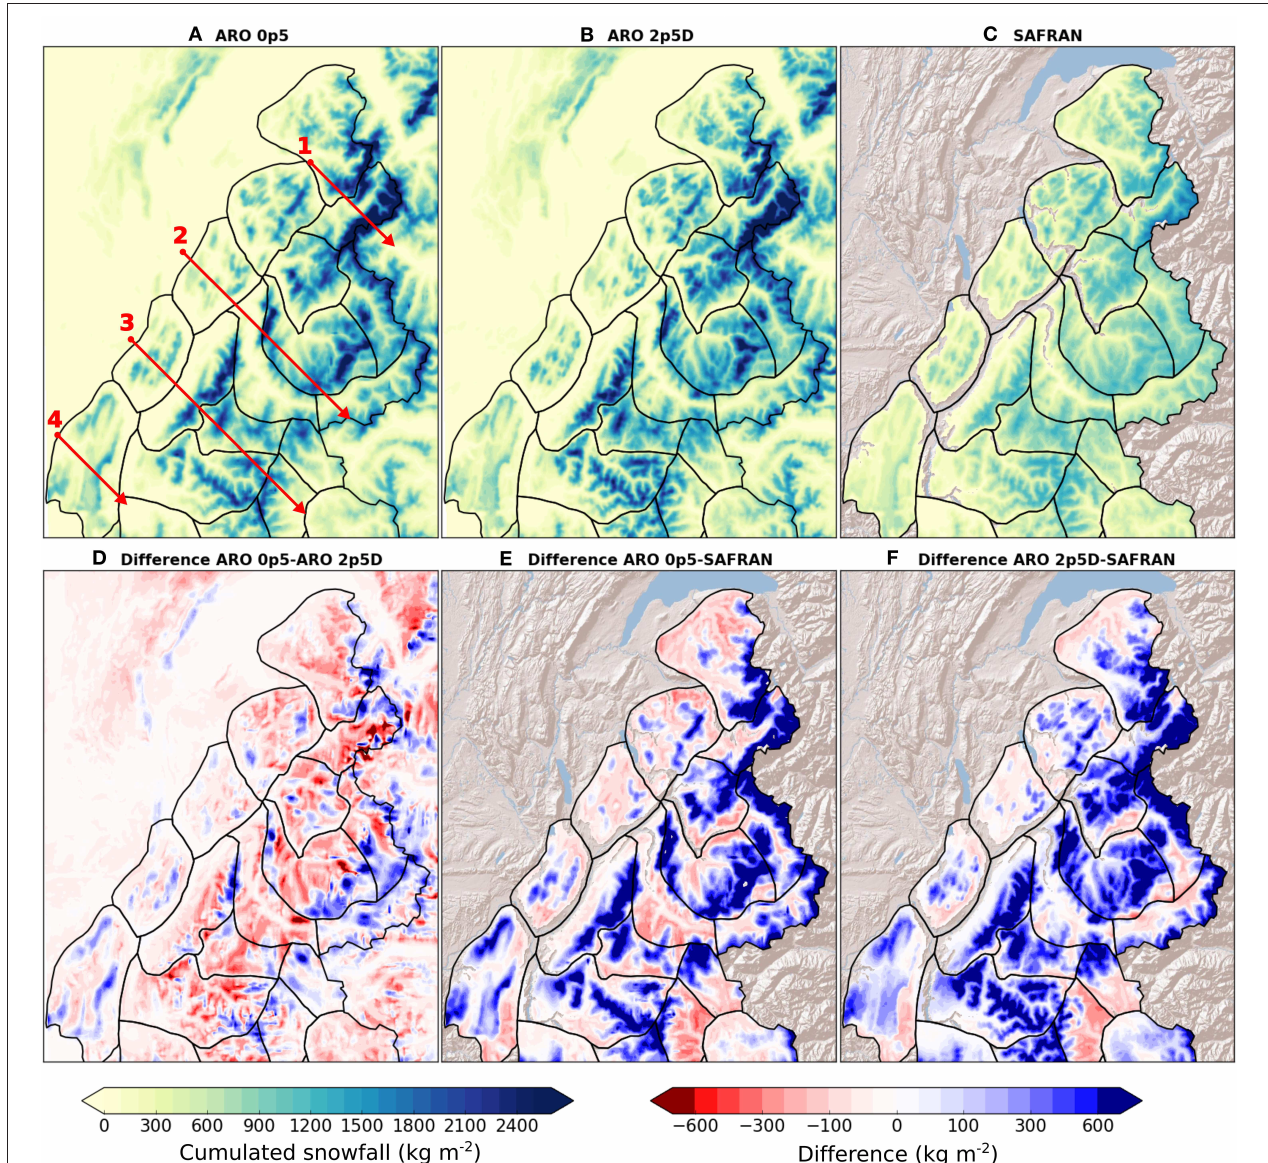
FIGURE 2 | Total snowfall from September 1st 2011 to June 30th 2012 for the different precipitation datasets: (A) AROME 500 m (ARO_0p5), (B) downscaled AROME 2.5 km (ARO_2p5D), and (C) SAFRAN. Maps (D–F) : differences between the datasets. SAFRAN data are only available within the limits of the massifs (black lines). Map (A) shows the location of the four transects detailed on Figure 4